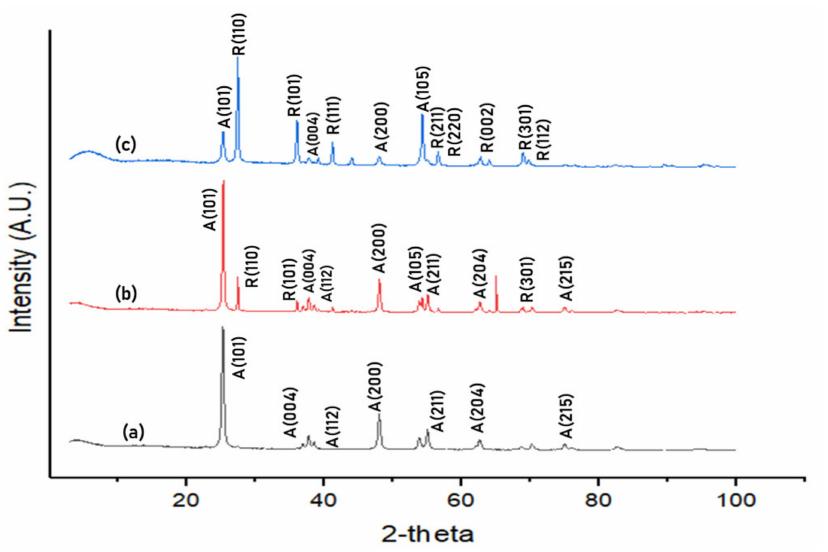
Figure 4. XRD patterns. ( a ) THN-400, ( b ) THN-500, ( c ) THN-600.